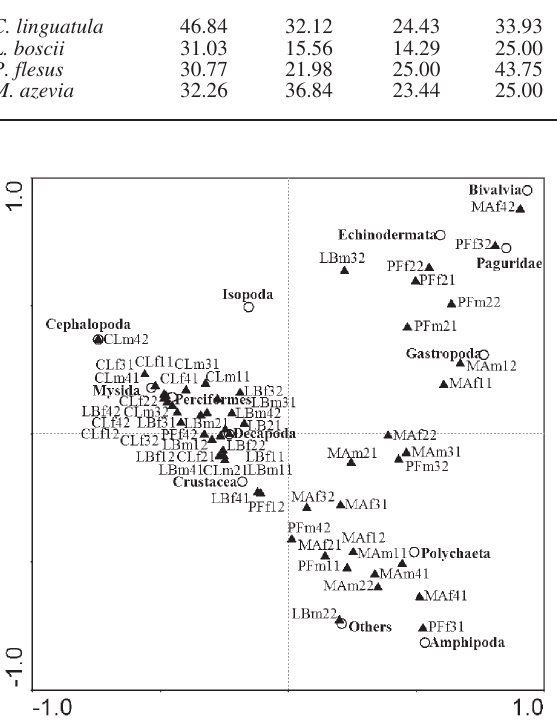
Fig . 1. – Ordination diagrams of the correspondence analyses performed on numerical index values of prey found in guts of C. linguatula (CL), L. boscii (LB), P. flesus (PF) and M. azevia (MA) (f, females; m, males; 1, winter; 2, spring; 3, summer; 4, autumn; 1, size class I; 2, size class